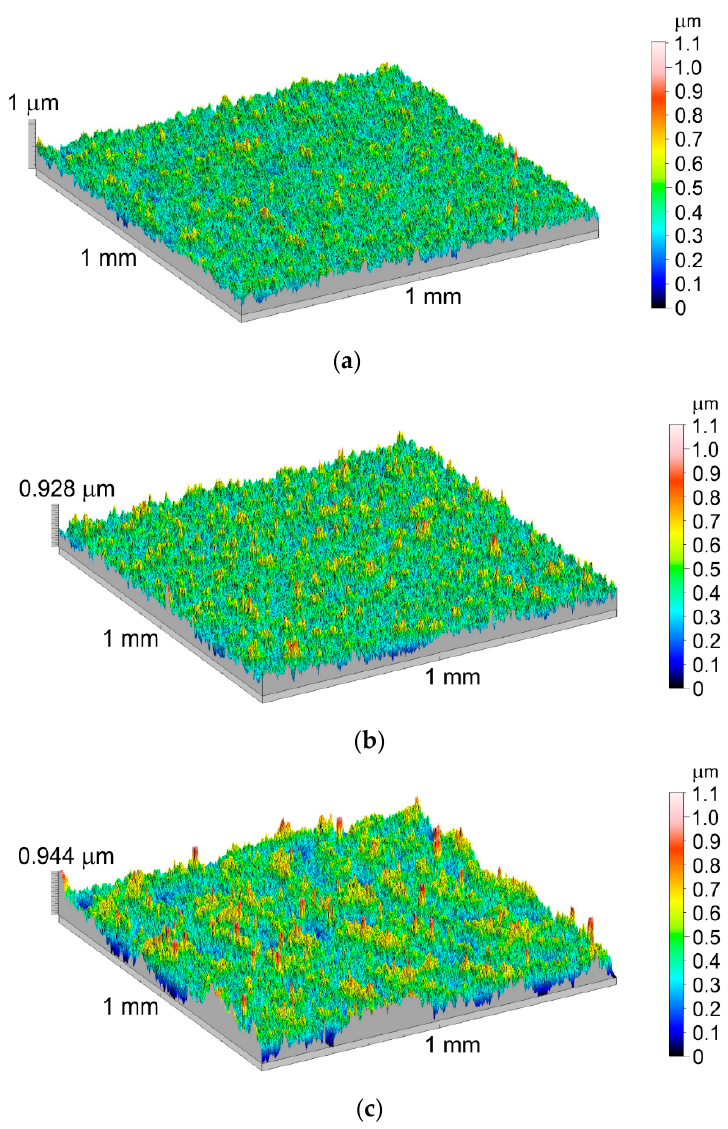
Figure 4. Geometric structure of the Ti ‐ 6Al ‐ 7Nb alloy surface after oxidation for 72 h at: ( a ) 600 °C; ( b ) 700 °C; ( c ) 800 °C.